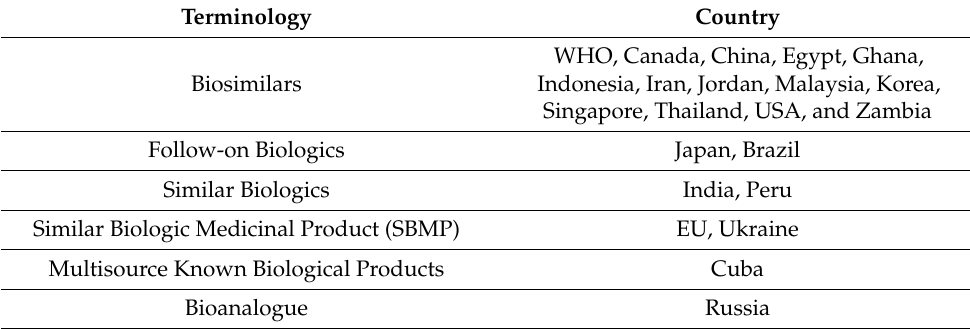
Table 1. Designation of off-patent biologics across the globe as of 2022.